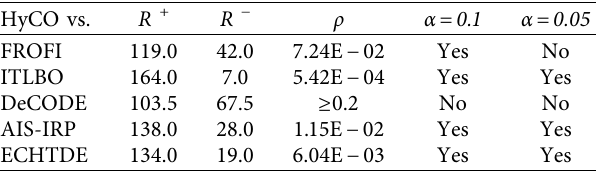
Table 7: Results of HyCO and other compared algorithms by the multiple-problem Wilcoxon test on 18 COPs with 30d from CEC 2010. HyCO vs.